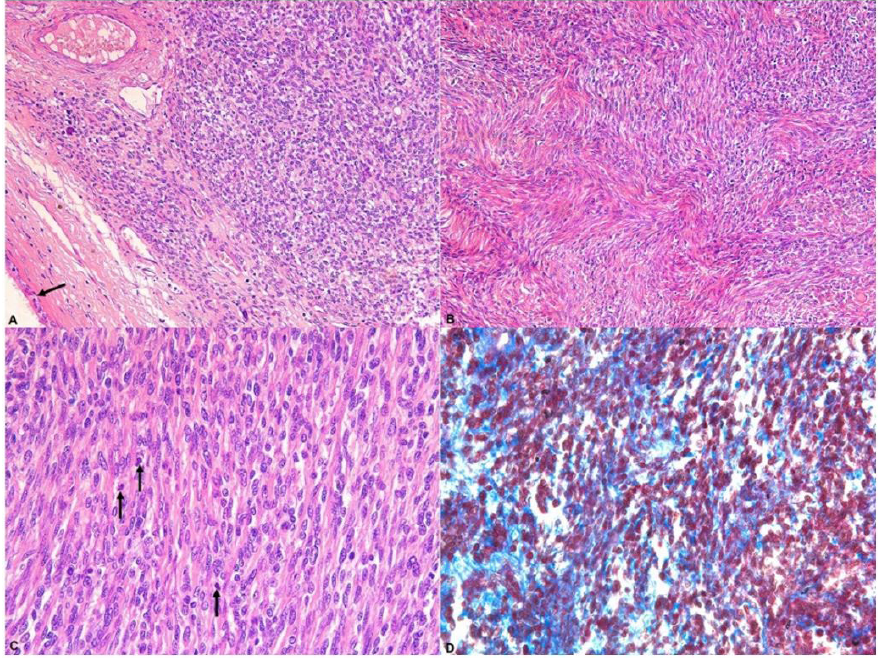
Figure 5. Histopathology of nasal neoplasm. (A) Infiltrative mesenchymal cells, arranged in solid bundles, close to the respiratory epithelium (arrow). Hematoxylin and eosin (H&E) staining, x200; (B) Infiltrative mesenchymal cells, arranged in solid bundles along multiple axes. H&E, x200; (C) Larger increase of proliferation shown in figure A and B. Spindle shaped mesenchymal cells, with eosinophilic cytoplasm and very imprecise cytoplasmic boundaries. The nuclei are spindle-shaped, with widely distributed chromatin, and 1 to 3 prominent nucleoli. Note some mitosis figures (arrows). H&E, x400; (D) Neoplastic proliferation of mesenchymal cells containing cytoplasm stained blue with Masson’s Trichrome,